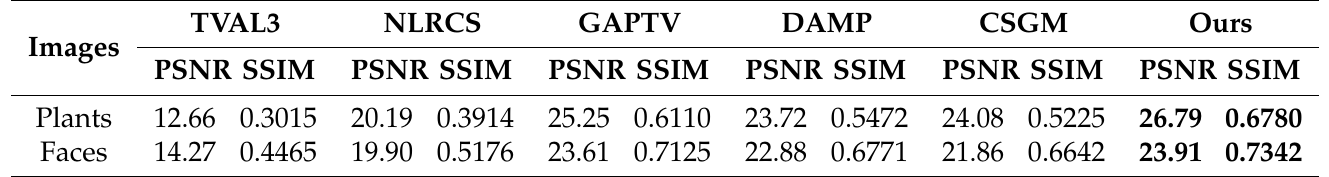
Figure 8. Some reconstruction samples of plant seedling and face images adding salt-and-pepper noise with cr = 10 and θ = 0.02. The ground truth, noisy images, and images reconstructed by various methods are illustrated. Table 4. Average PSNR and SSIM comparisons using images with salt-and-pepper noise. Bold indicates the best